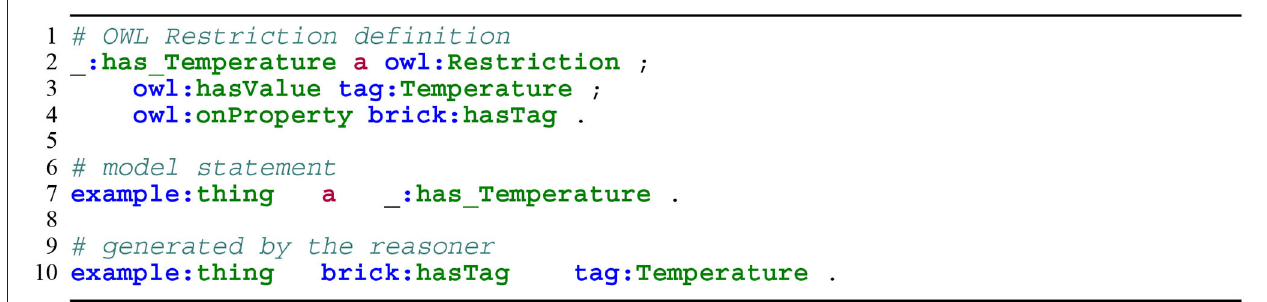
FIGURE 5 | An example of an OWL Restriction class encoding the association with the Temperature tag in Brick.